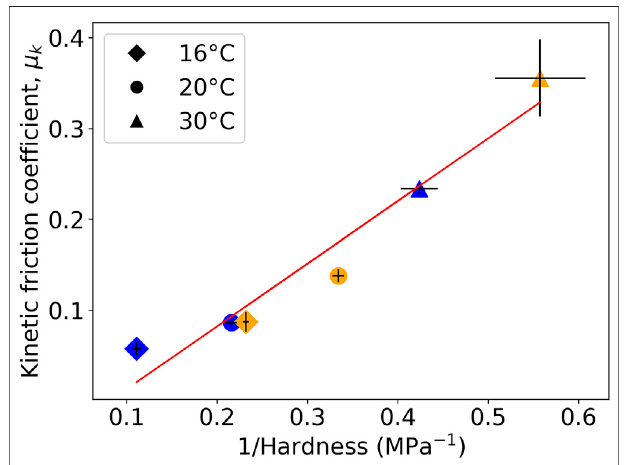
FIGURE6| Inversecorrelationbetweenthehardnessandkineticfriction coef fi cient for a range of coatings at 10% RH and 20 ° C. Vertical error bars indicate the standard deviation in μ k , horizontal error bars indicate the propagated standard error in the mean hardness. The line is a guide to the eye. The outlier point in the lower right is data from the Latex (XG)